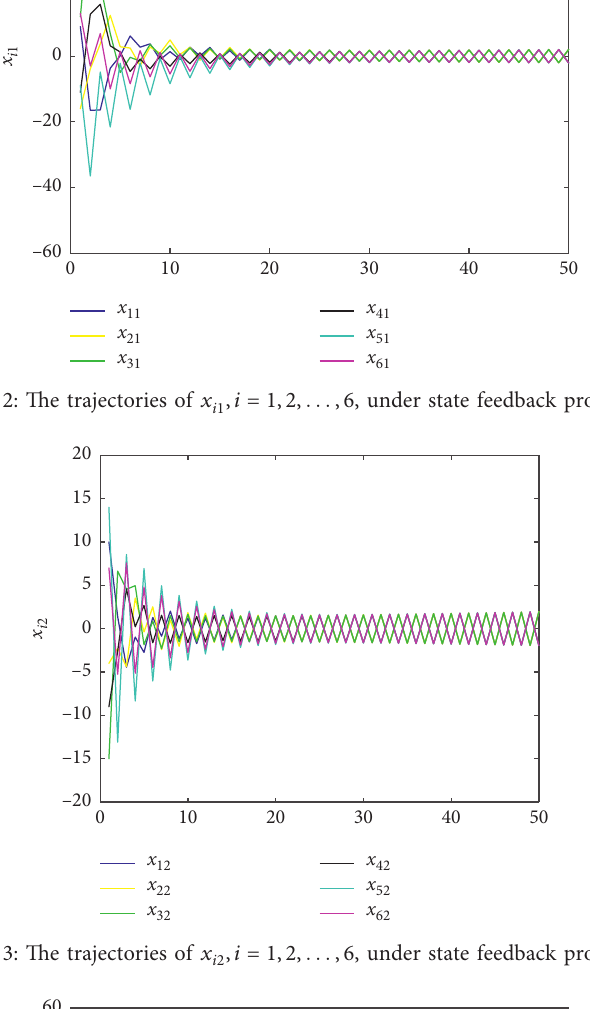
Figure 3: The trajectories of x